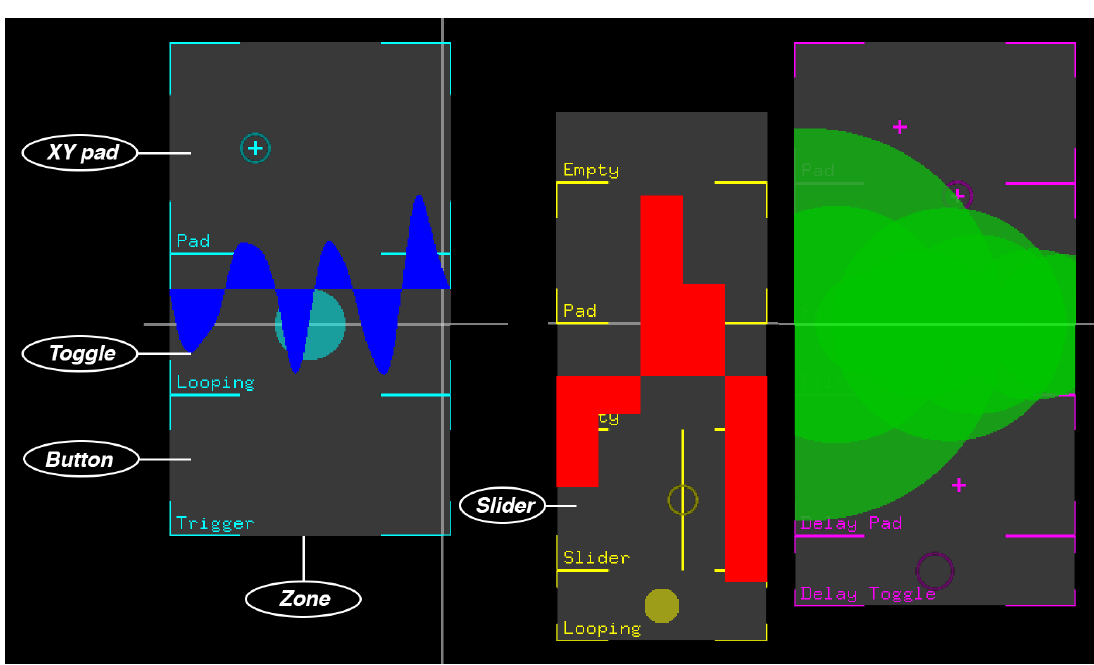
Figure 1. Example of an AVUI layout, with captions pointing to the different UI